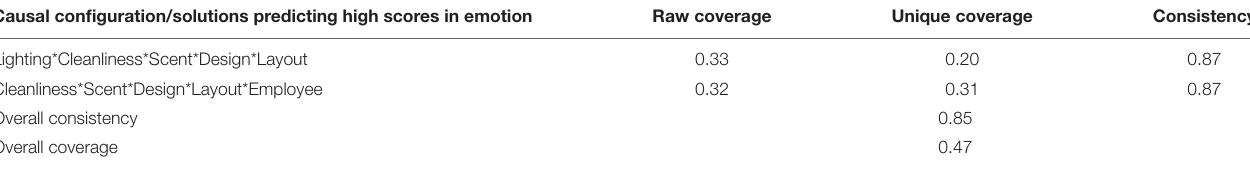
TABLE 4 | Core-periphery conditions producing strong emotions. Causal configuration/solutions predicting high scores in